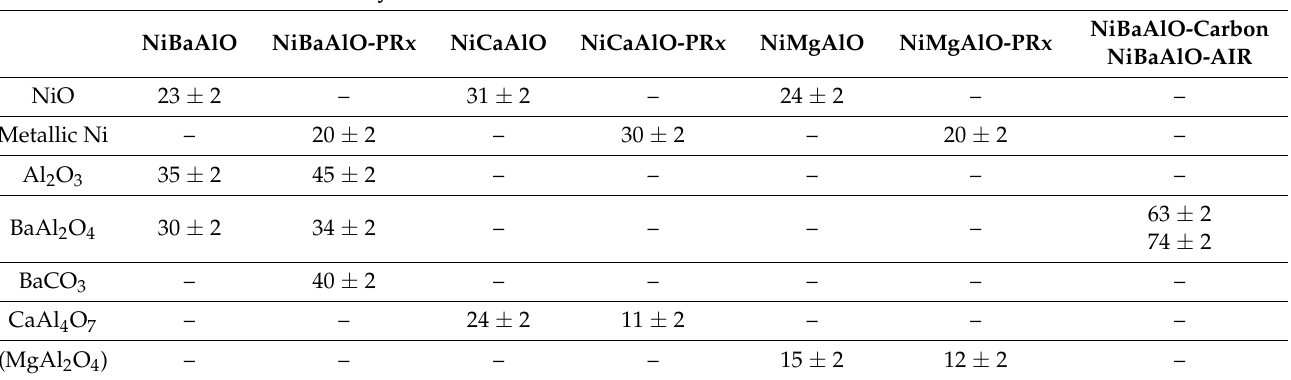
Figure 1. XRD Diffractograms of NiBaAlO, NiMgAlO, and NiCaAlO samples, where the main de- tected phases have been indicated (JCPDS: NiO = 01-073-1519; Al 2 O 3 = 00-042-1468, MgAl 2 O 4 =00- 001-157, CaAl 2 O 4 = 00-017-0306). Table 2. Crystallite size (diffraction dominion) calculated from Scherrer formula for NiBaAlO, NiMgAlO, and NiCaAlO samples.